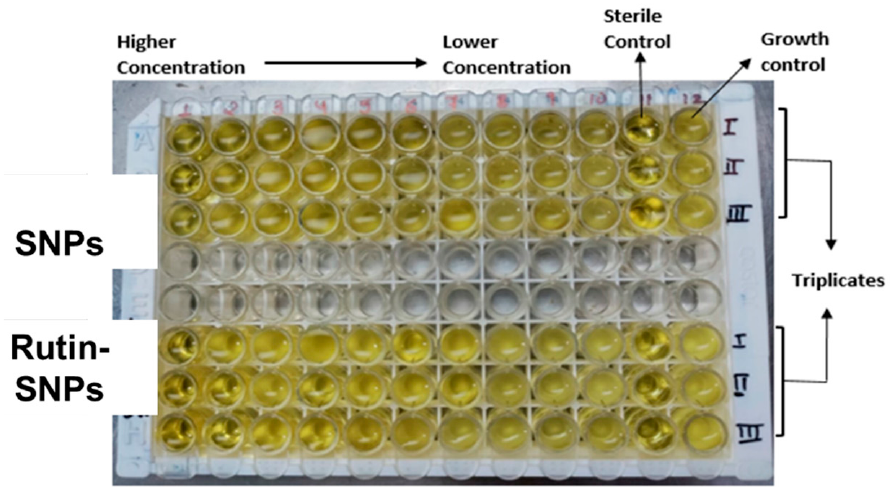
Figure 7. Microtiter plate wells showing MIC of SNPs and Rutin-SNPs.